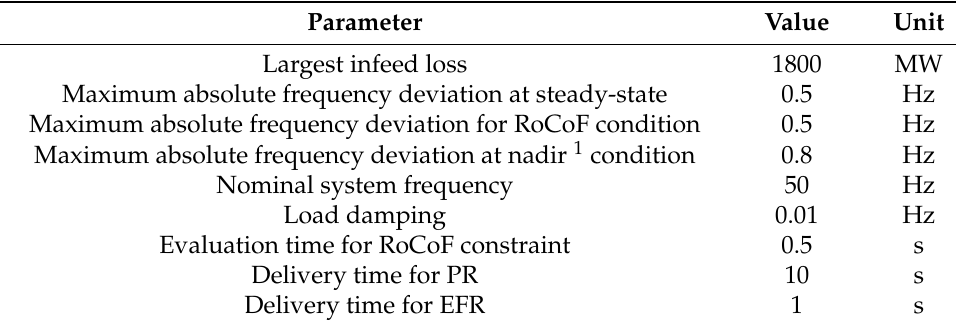
Table 2. Assumptions on system-level characteristics